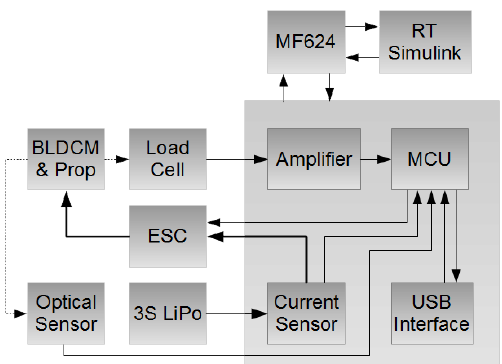
Figure 2. Block diagram of the measuring test stand (BLDCM & Prop—BrushLess DC Motor and Propeller, ESC—Electronic Speed Controller, 3S LiPo—LiPo batteries, MCU—Master Control Unit, RT Simulink—Real Time Toolbox Simulink, MF624—input/output board).